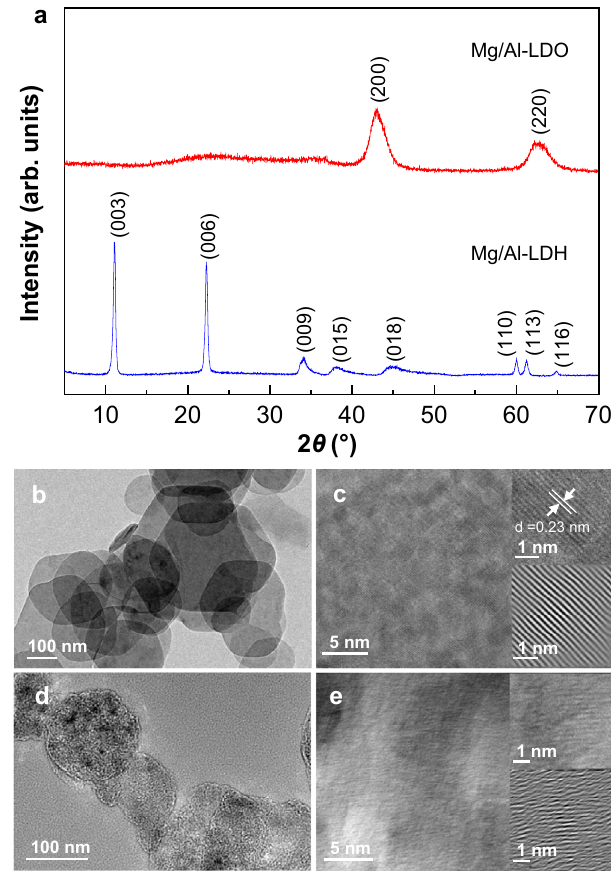
Fig.2|XRDpatternsandelectronmicroscopyimagesofMg/Al-LDHandMg/Al- LDO.a XRDpatternsofMg/Al-LDHandMg/Al-LDO.TEM( b )andHRTEM( c )images of Mg/Al-LDH. TEM ( d ) and HRTEM ( e ) images of